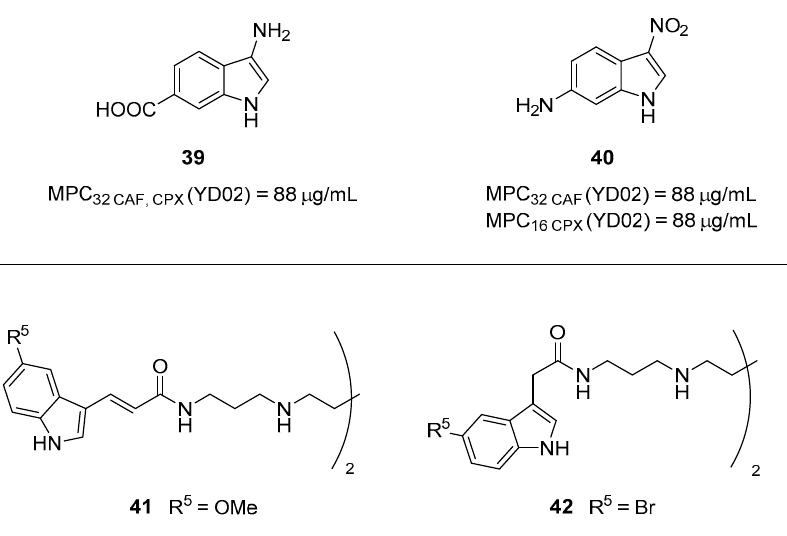
Figure 14. Indole derivatives reported as Gram-negative EPIs.